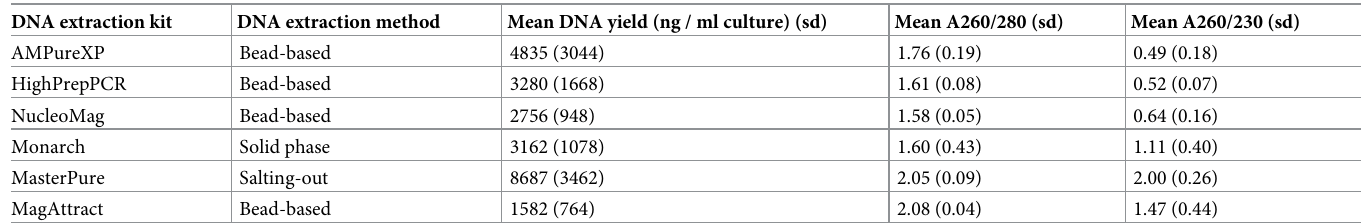
Table 1. Performance comparison of DNA extraction methods. DNA extraction kit